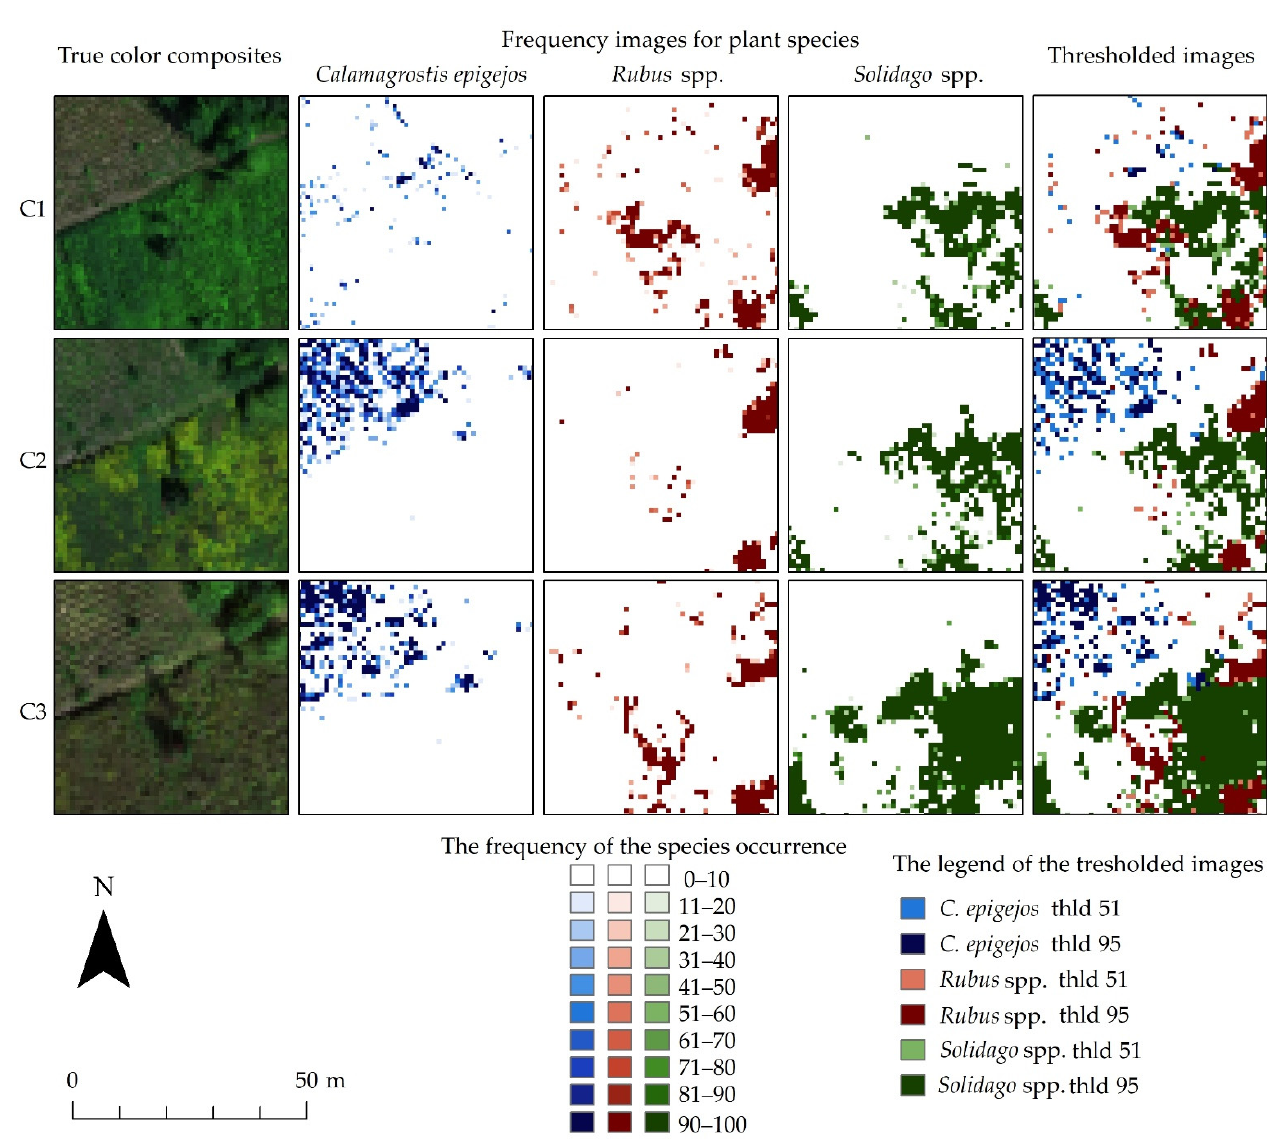
Figure 7. The images show an exemplary fragment of the frequency images for Calamagrostis epigejos , Rubus spp. and Solidago spp. for three campaigns (C1, C2, C3) with colored classes for different ranges of the number of occurrences and true color composites of the HySpex hyperspectral data. Then, the frequency images were thresholded (thresholds 51 and 95) and combined to obtain a map with classes indicating the presence of a species with lower ( Rubus spp. threshold 51, Solidago spp. threshold 51 and Calamagrostis epigejos threshold 51) and higher certainty ( Rubus spp. threshold 95, Solidago spp. threshold 95 and Calamagrostis epigejos